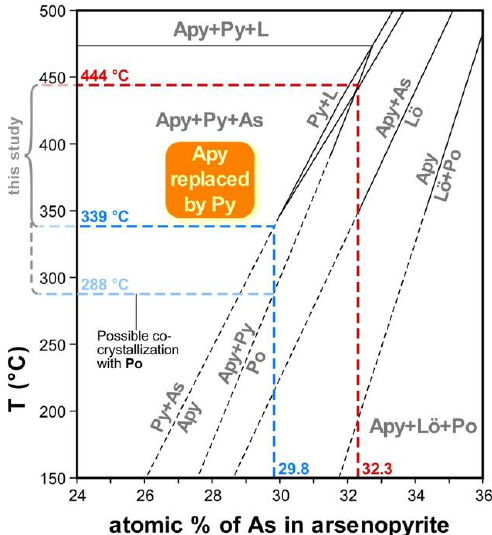
Figure 14. Binary temperature composition plot showing arsenopyrite composition in the f (S 2 ) buffered arsenopyrite + pyrite + pyrrhotite and pyrrhotite + arsenopyrite + pyrite assemblages (fields are after [54]). Key: Apy = arsenopyrite, As = native arsenic, L = liquid, Lö = löllingite, Po = pyrrhotite, and Py = pyrite.